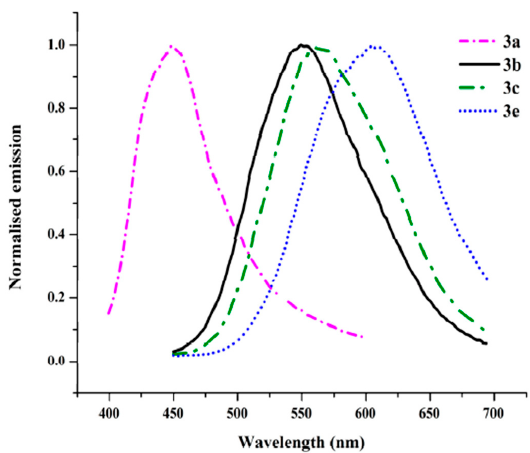
Figure 3. Normalized emission bands of 2-substituted-thiazolo[5,4- b ]phenothiazine derivatives 3a − 3e (excitation with the corresponding longest wavelength absorption maxima).